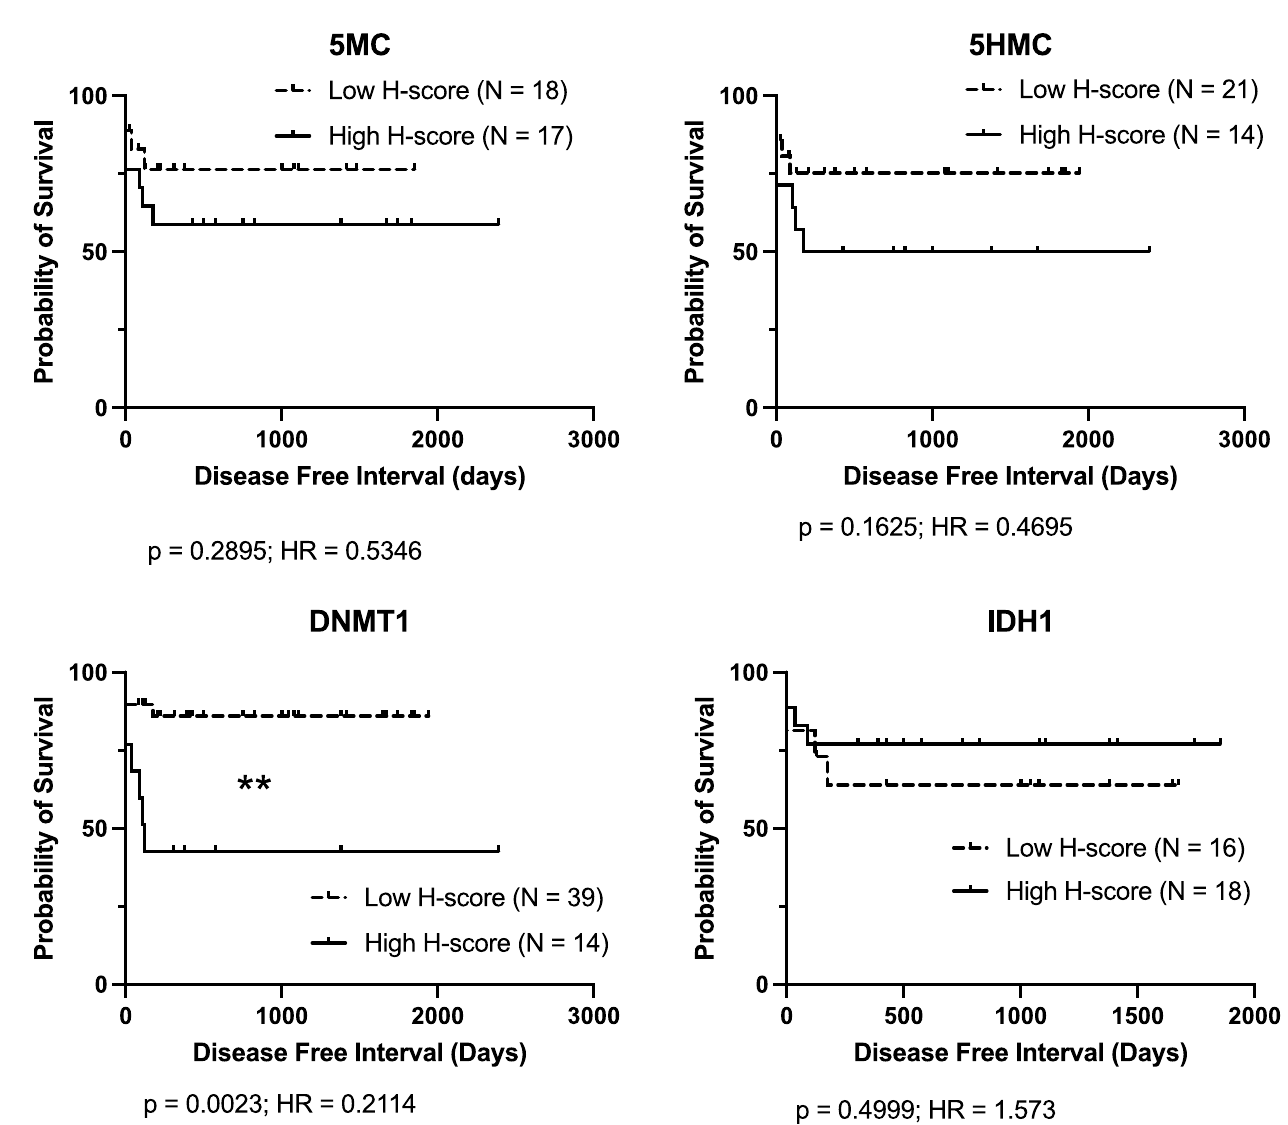
Fig 3. Kaplan-Meier survival curves for disease free interval (DFI) for dermal mast cell cancer cases stratified by immunolabelling H-score for each parameter. Logrank analysis indicates groups showing significant differences (p < 0.05). Cases lost to follow-up or still healthy at last follow-up are indicated by upward ticks on the curves, and were right-censored for